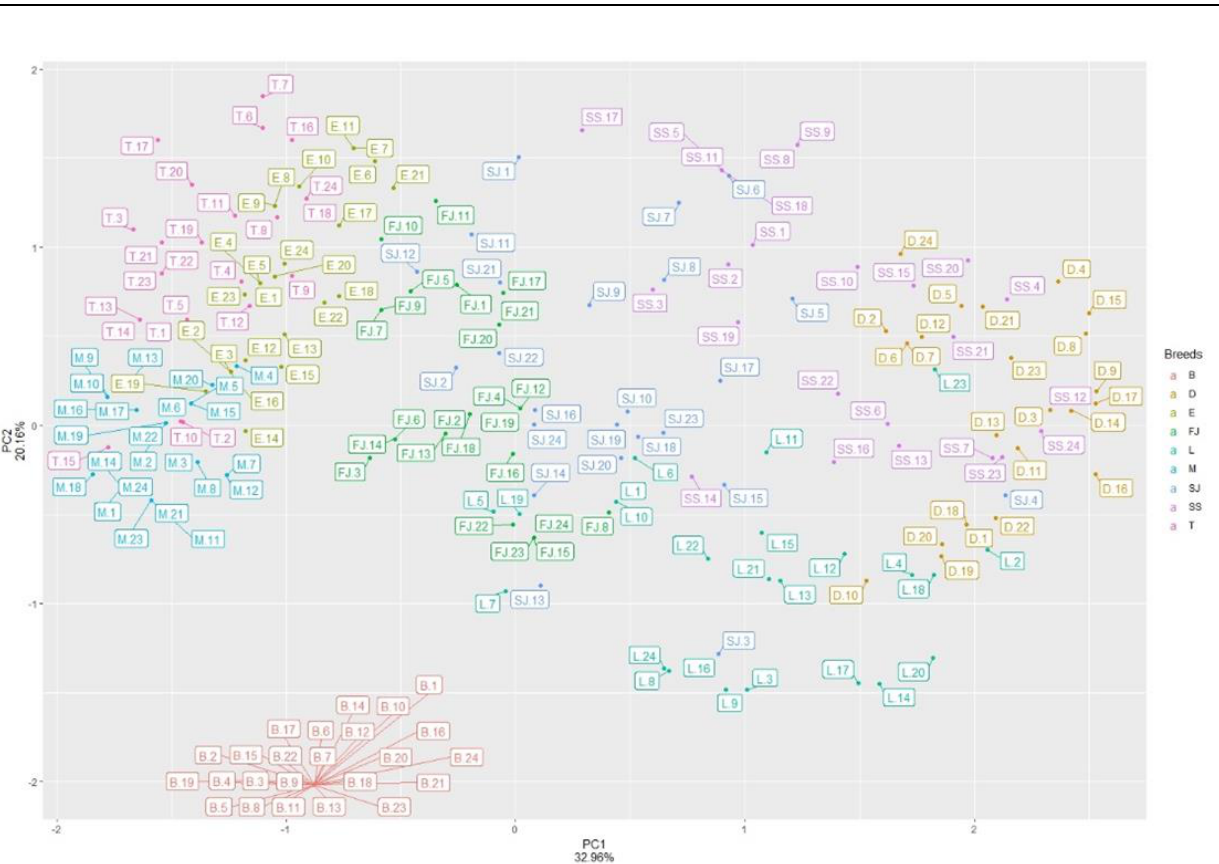
Figure 2. The principal component analysis (PCA) based on the results of the 24 individuals per breed. “B”, the Bama breed; “T”, the Tibetan breed; “D”, the Duroc breed; “L”, the Large White breed; “SJ”, the SuJiang breed; “SS”, the SuShan breed; “E”, the Erhualian breed; “M”, the Meishan breed; “FJ”, the Fengjing breed.